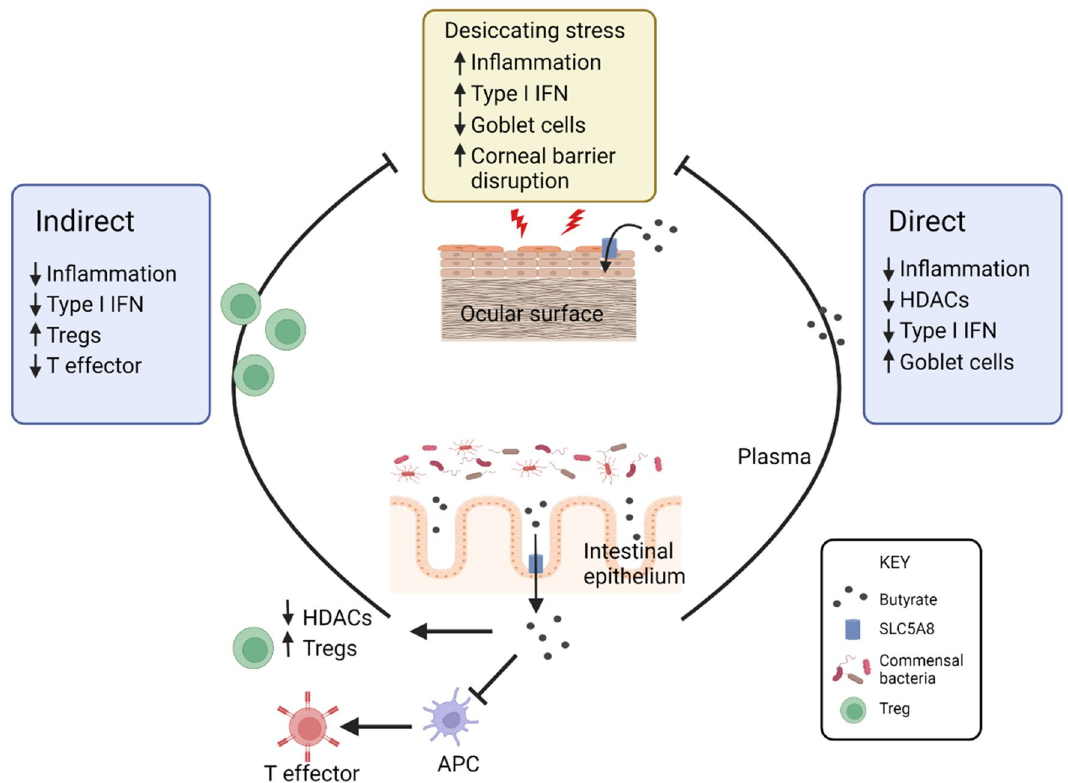
Figure 5. Proposed mechanisms for butyrate’s protective effect on the ocular surface. Butyrate may impact the ocular surface in two different ways, indirectly though modulation of immune cells and directly through interaction with ocular surface epithelium expressing SLC5A8 or other SCFA receptors and modulating gene expression through its HDAC inhibitory activity. APC, Antigen presenting cell; HDAC, histone deacetylase; IFN, interferon; Treg, regulatory T cell. Figure drawing created with